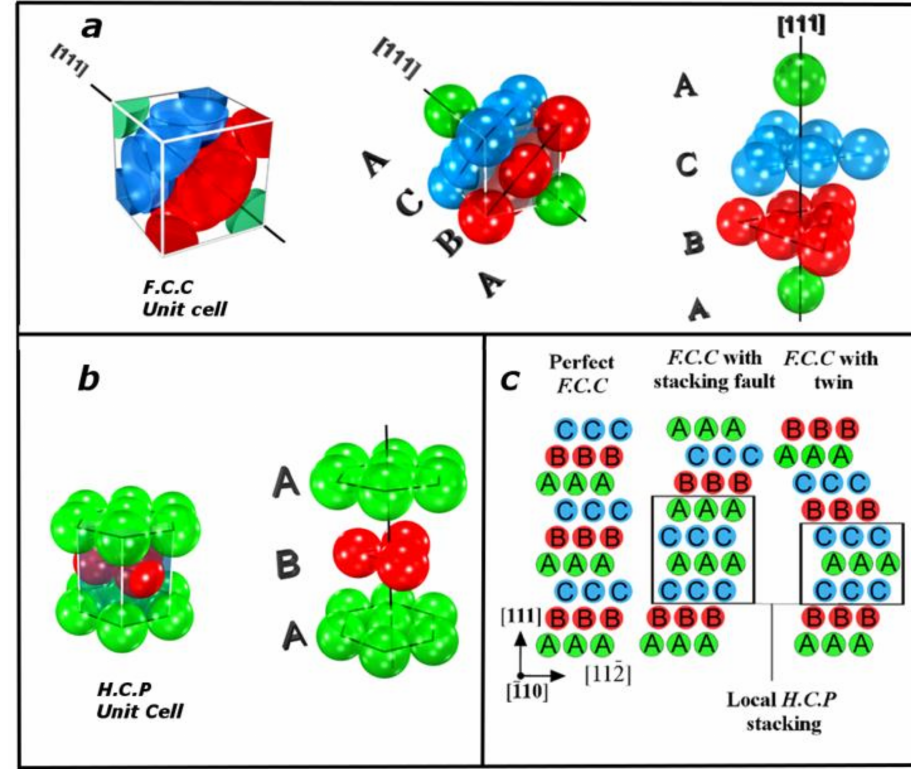
Figure 1. Representation of the stacking fault sequence in a f.c.c. structure. ( a ) represent the sequence for a f.c.c. structure, ( b ) h.c.p. structure, and ( c ) f.c.c. to h.c.p. and